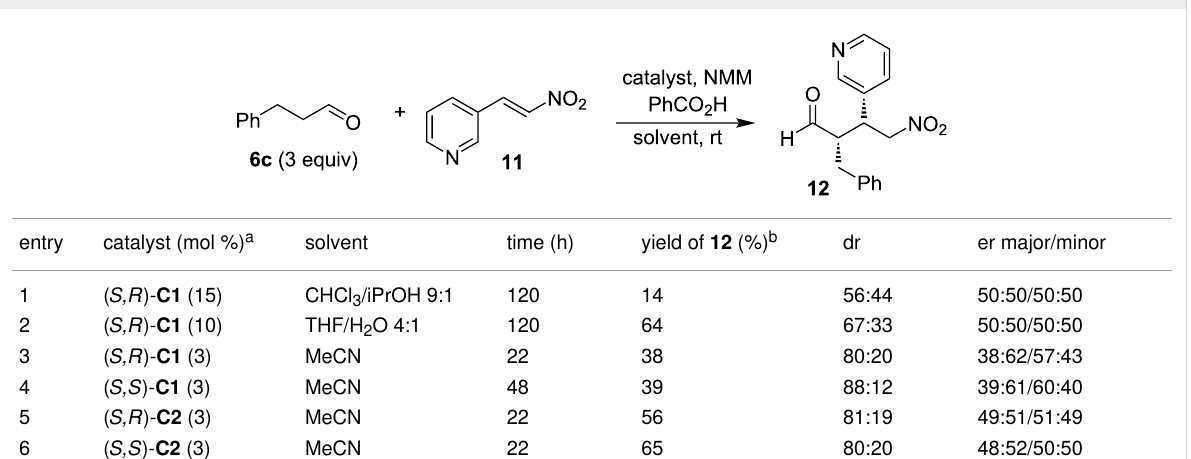
Table 2: Michael addition of 3-phenylpropanal ( 6c ) to nitroalkene 11 .